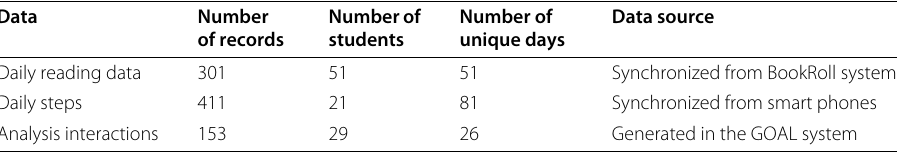
Table 5 Data collected in the GOAL